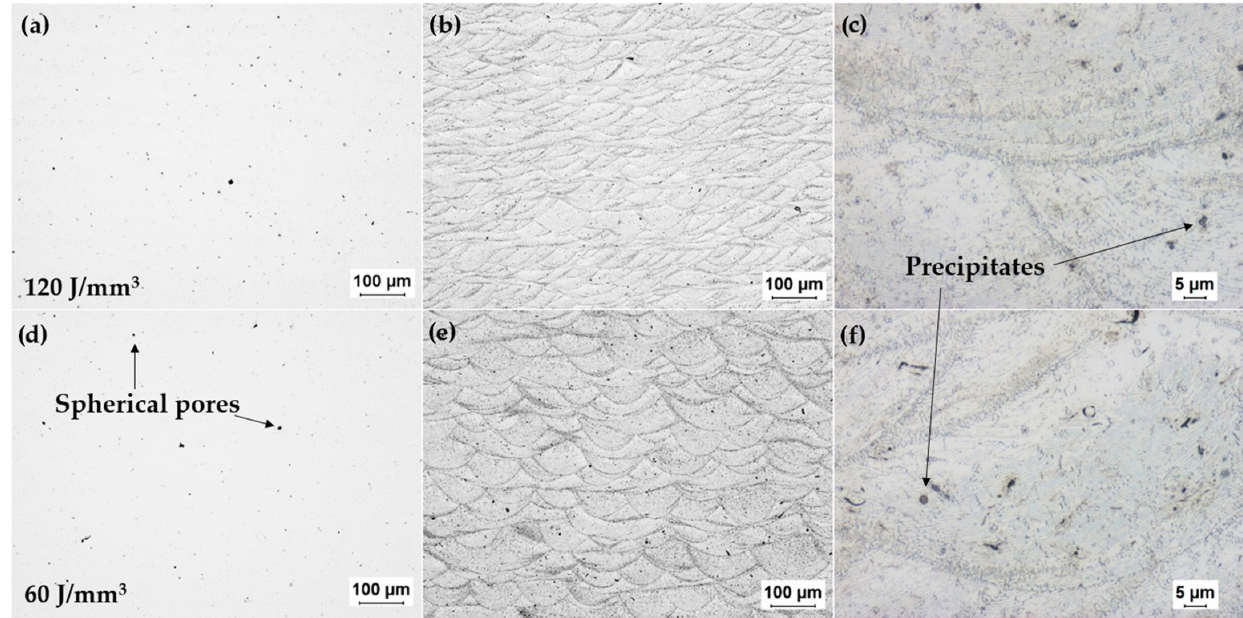
Figure 2. LOM images of the cross-sections parallel to the build direction of the two samples processed by PBF-LB ( a ) before and ( d ) after etching; ( b ), ( c ) and ( e ), ( f ), where ( a – c ) correspond to the samples processed with ED = 120 J/mm 3 , and the ( d – f ) correspond to the samples processed with a lower energy density of ED = 60 J/mm 3 .